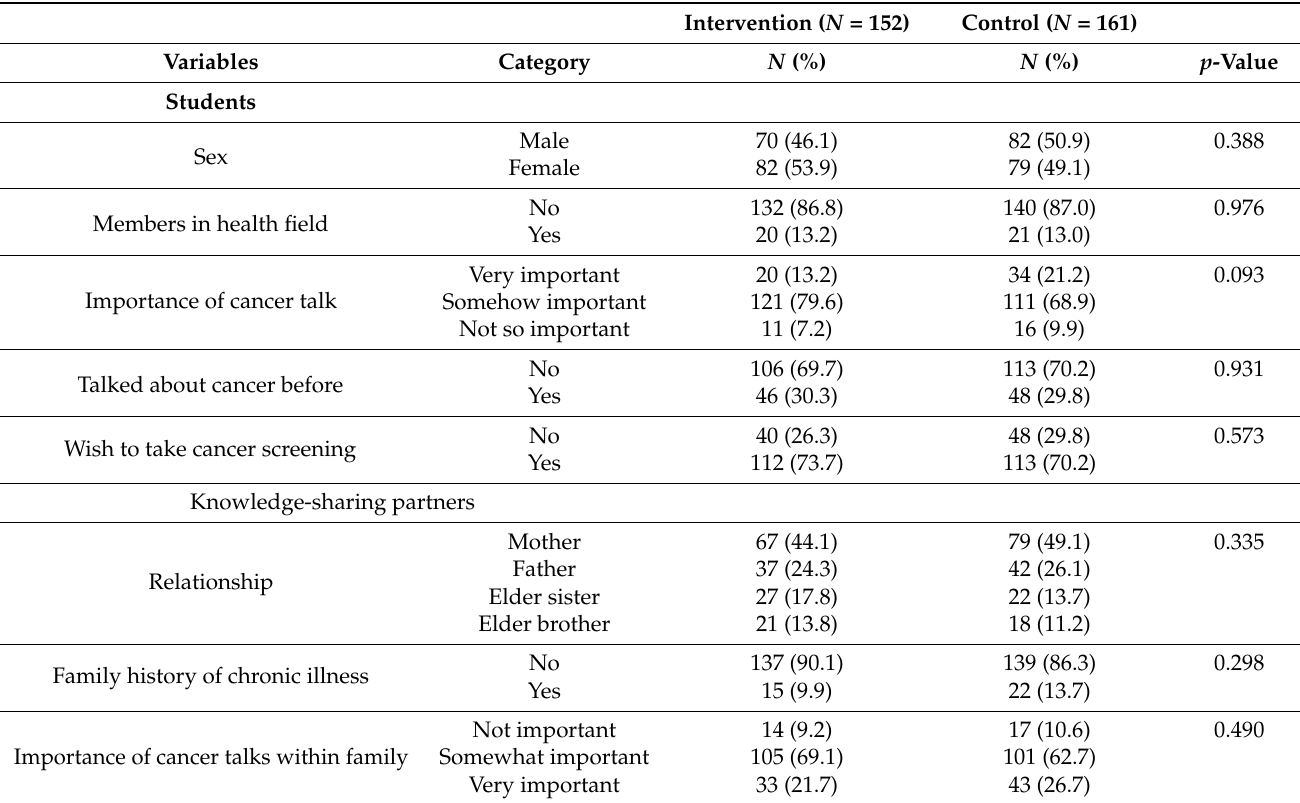
Table 1. Socio-personal information of